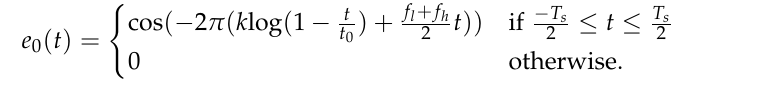
Figure 2. Transmitter diagram, where N SF denotes the spreading factor, and Π T function of duration T s